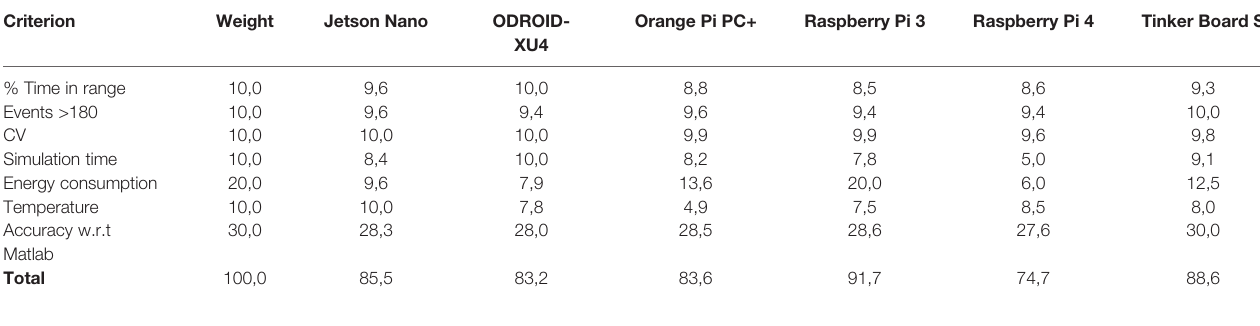
TABLE 5 | Overall performance evaluation for embedded system selection.